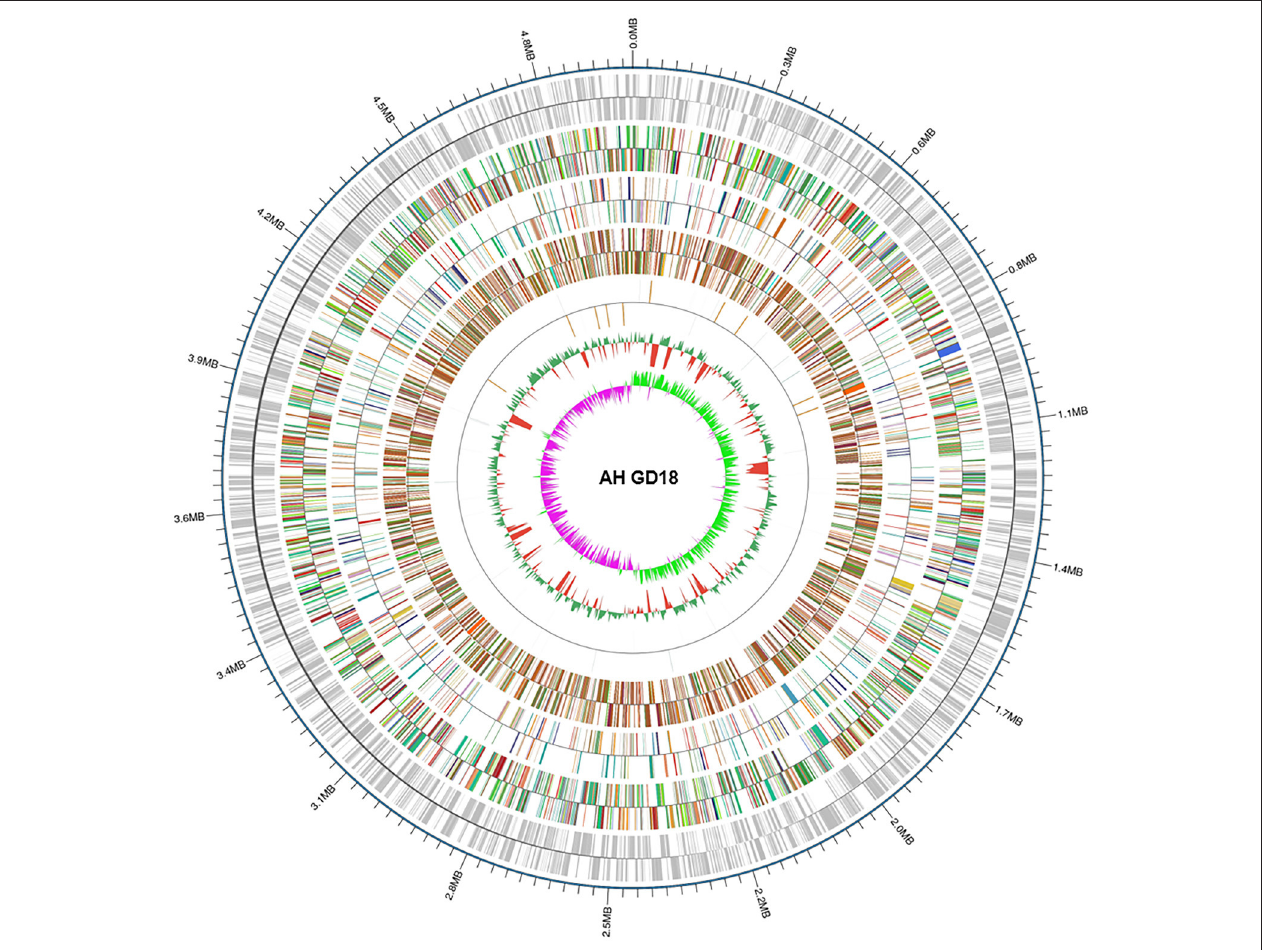
FIGURE 2 | Genome map of A. hydrophila GD18. Circular map for the whole genome of A. hydrophila GD18. From the outside to the center: genome sequence coordinates, gene annotation (COG, eggNOG, KEGG, and GO categories), ncRNA, GC content, and GC skew (G – C/G + C).